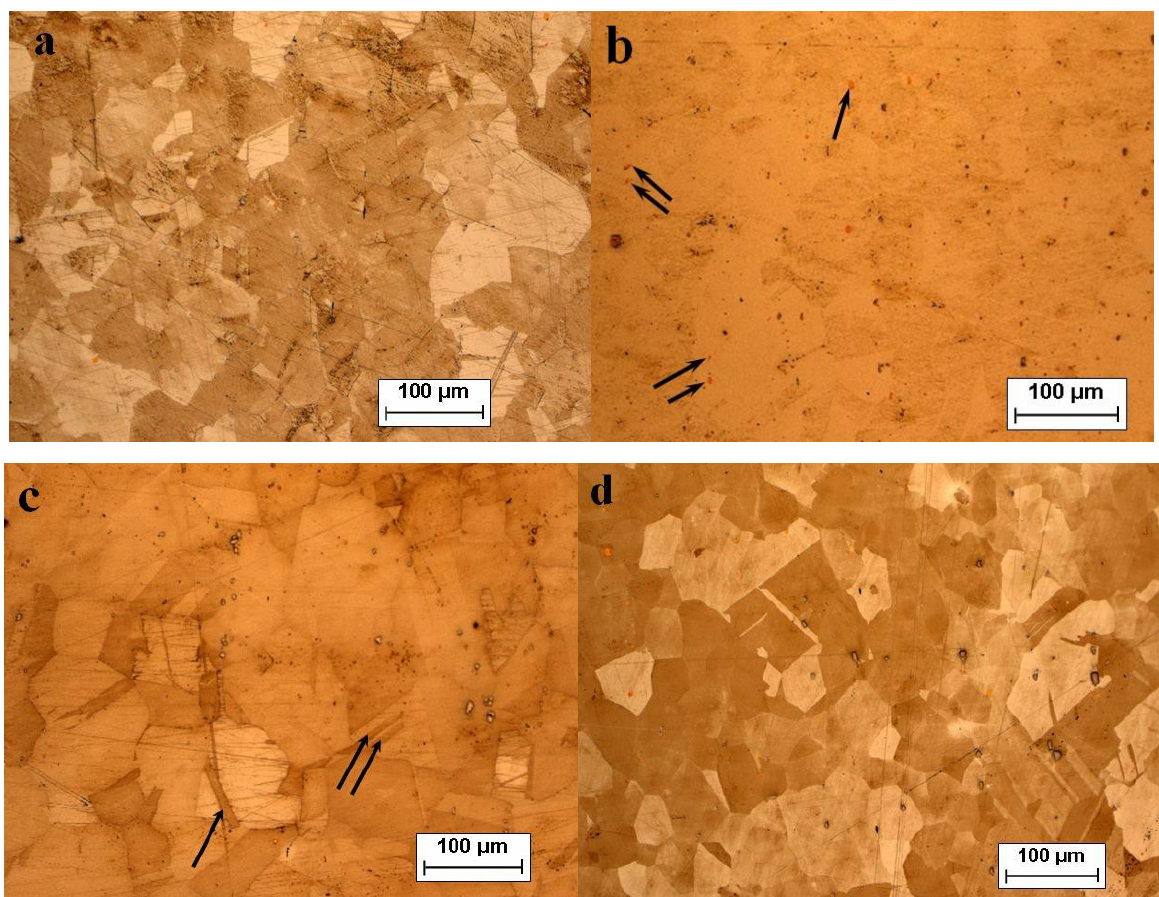
Figure 1. Microstructure of the surface of Inconel 718 superalloy samples after heat treatment according to various modes.( a ) — as-received state, ( b ) — mode 3 (Table 2), ( c ) — mode 5 (Table 2), ( d ) — mode 7 (Table 2). The arrows in the photos indicate the reinforcing intermetallic —γ’ -phases ( b ) and twins ( c ).